Question: Produce a descriptive caption suitable for publication.
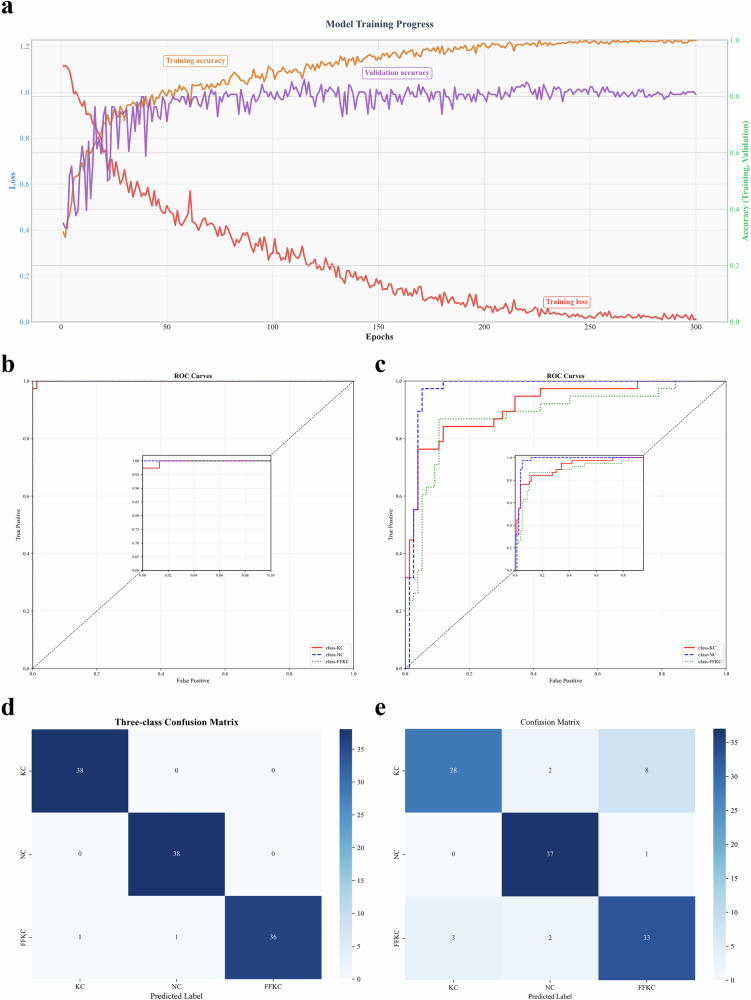
Answer: Model performance. a The training curves for the best-performing model; b The Receiver Operating Characteristic (ROC) curves on the Test Dataset; c The ROC curves on the Validation Dataset; d Confusion Matrix of the Model on the Test Dataset; e Confusion Matrix of the Model on the Validation Dataset.